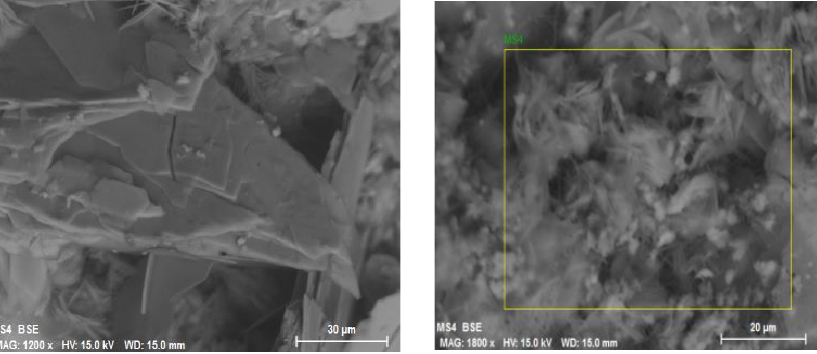
Figure 10. SEM image of cement paste with NC 6%.